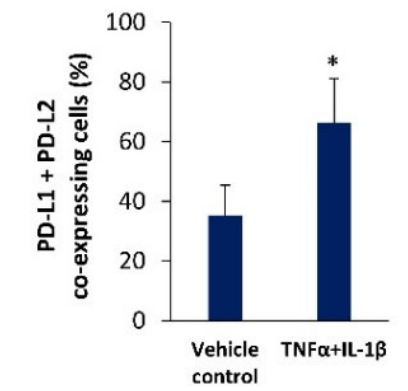
Figure 1. Joint stimulation by TNF α + IL-1 β promotes the proportion of PD-L1 + PD-L2 co-expressing MDA-MB-231 cells. ( A ) MDA-MB-231 cells (MDA) were stimulated by TNF α and/or IL- β (TNF α